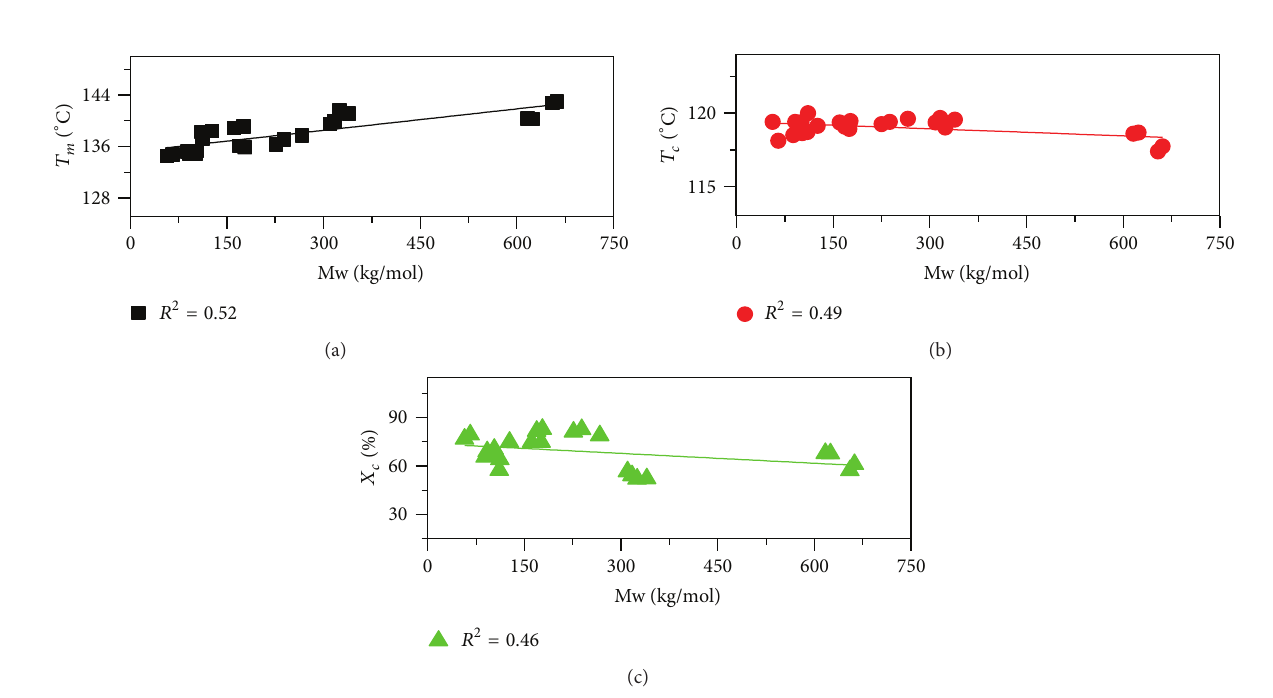
Figure 6: Correlation of Mw with (a) 𝑇 𝑚 , (b) 𝑇 𝑐 , and (c) 𝑋 𝑐